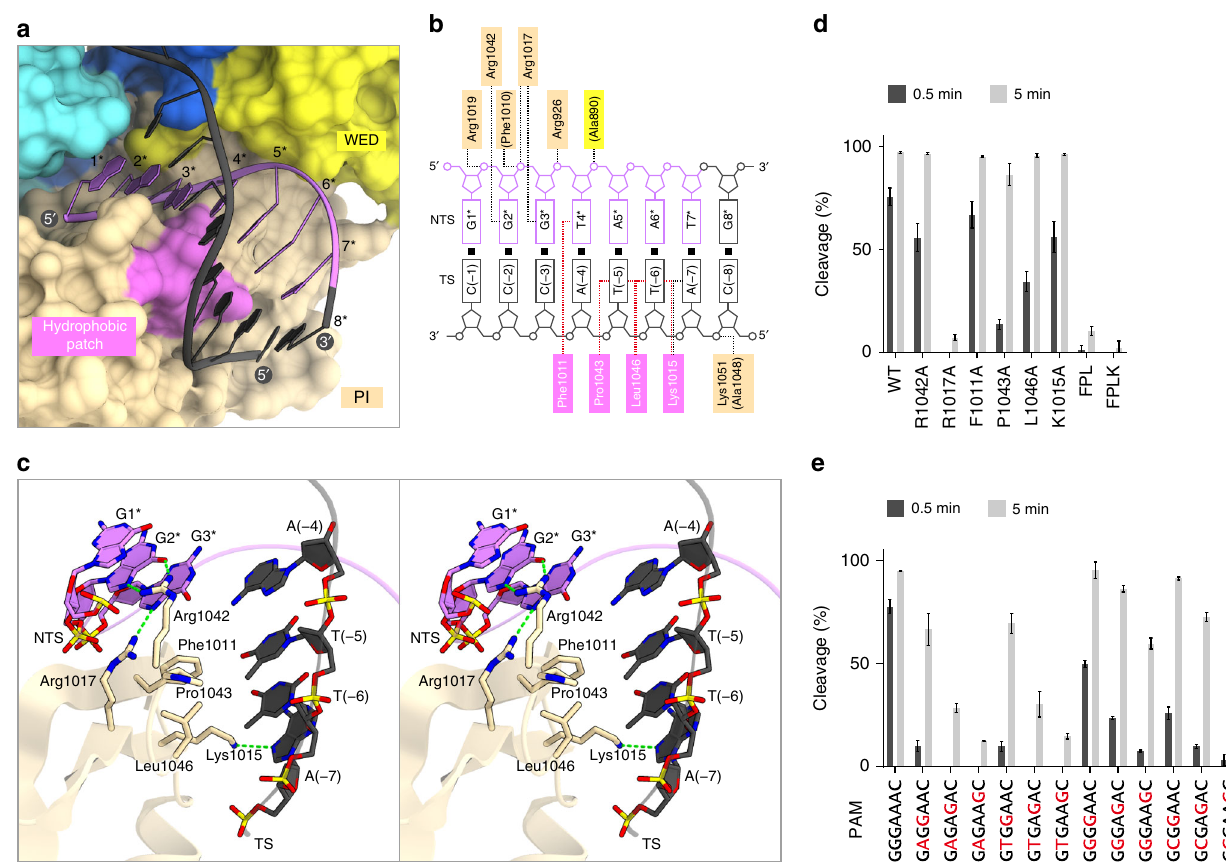
Fig. 6 Protospacer adjacent motif (PAM) recognition by Corynebacterium diphtheriae Cas9 (CdCas9). a Binding of the PAM duplex to CdCas9. b Schematics of the PAM recognition by CdCas9. Hydrogen bonds and hydrophobic interactions are depicted by black and red dashed lines, respectively. c Recognition of the GGGTAAT PAM (stereo view). Hydrogen bonds are shown as dashed lines. d Effects of the mutations on the PAM-interacting residues. The linearized plasmid target with the GGGAAAC PAM was incubated with the wild-type or the mutants of CdCas9, together with the single-guide RNA (sgRNA22), at 37 °C for 0.5 and 5 min. FPL, F1011A/P1043A/L1046A; FPLK, F1011A/K1015A/P1043A/L1046A. e Functional importance of the second PAM nucleotide. The linearized plasmid targets bearing the different PAMs were incubated with CdCas9-sgRNA22 at 37 °C for 0.5 and 5 min. Error bars represent s.d. from n = 3